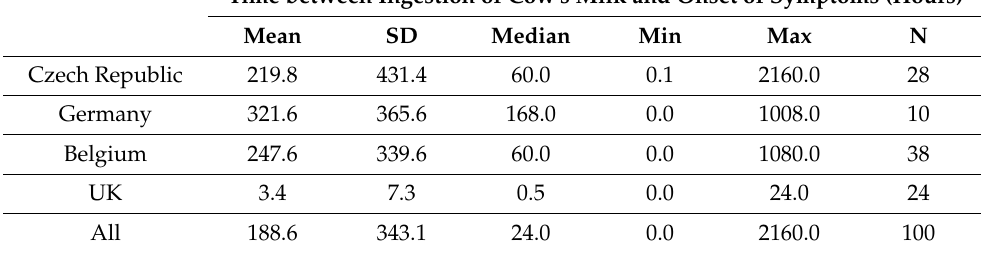
Table 6. Time between first intake of cow’s milk and onset of symptoms per country. Time between Ingestion of Cow’s Milk and Onset of Symptoms (Hours)